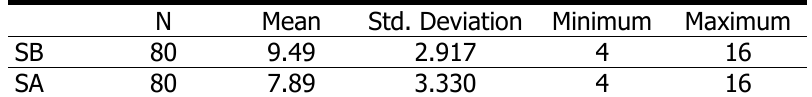
Table 7. Descriptive Statistics of Social